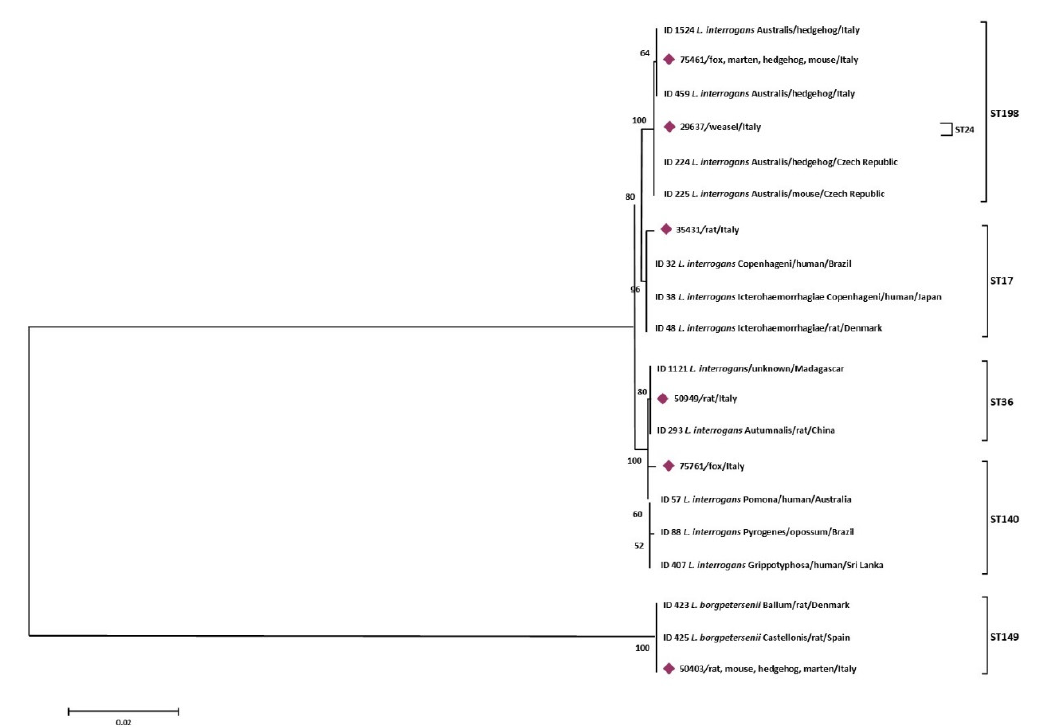
Figure 3. Phylogenetic tree based on concatenated sequences of 7 housekeeping loci of the 6 STs obtained in this study was constructed by using the Maximum Likelihood method based on the Tamura 3-parameter model. The tree with the highest log likelihood ( − 6579,6990) is shown. The percentage of trees in which the associated taxa clustered together is shown next to the branches. The analysis involved 20 nucleotide sequences. All positions containing gaps and missing data were eliminated. There were a total of 3108 positions in the final dataset.